Question: State the chart type depicted above.
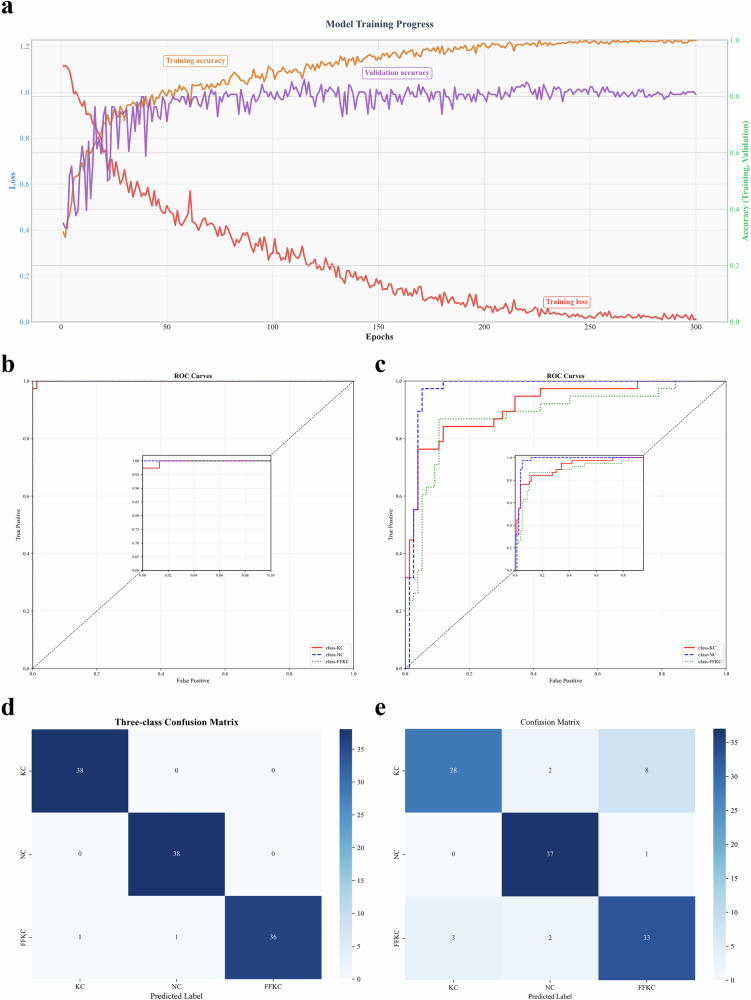
Answer: heatmap